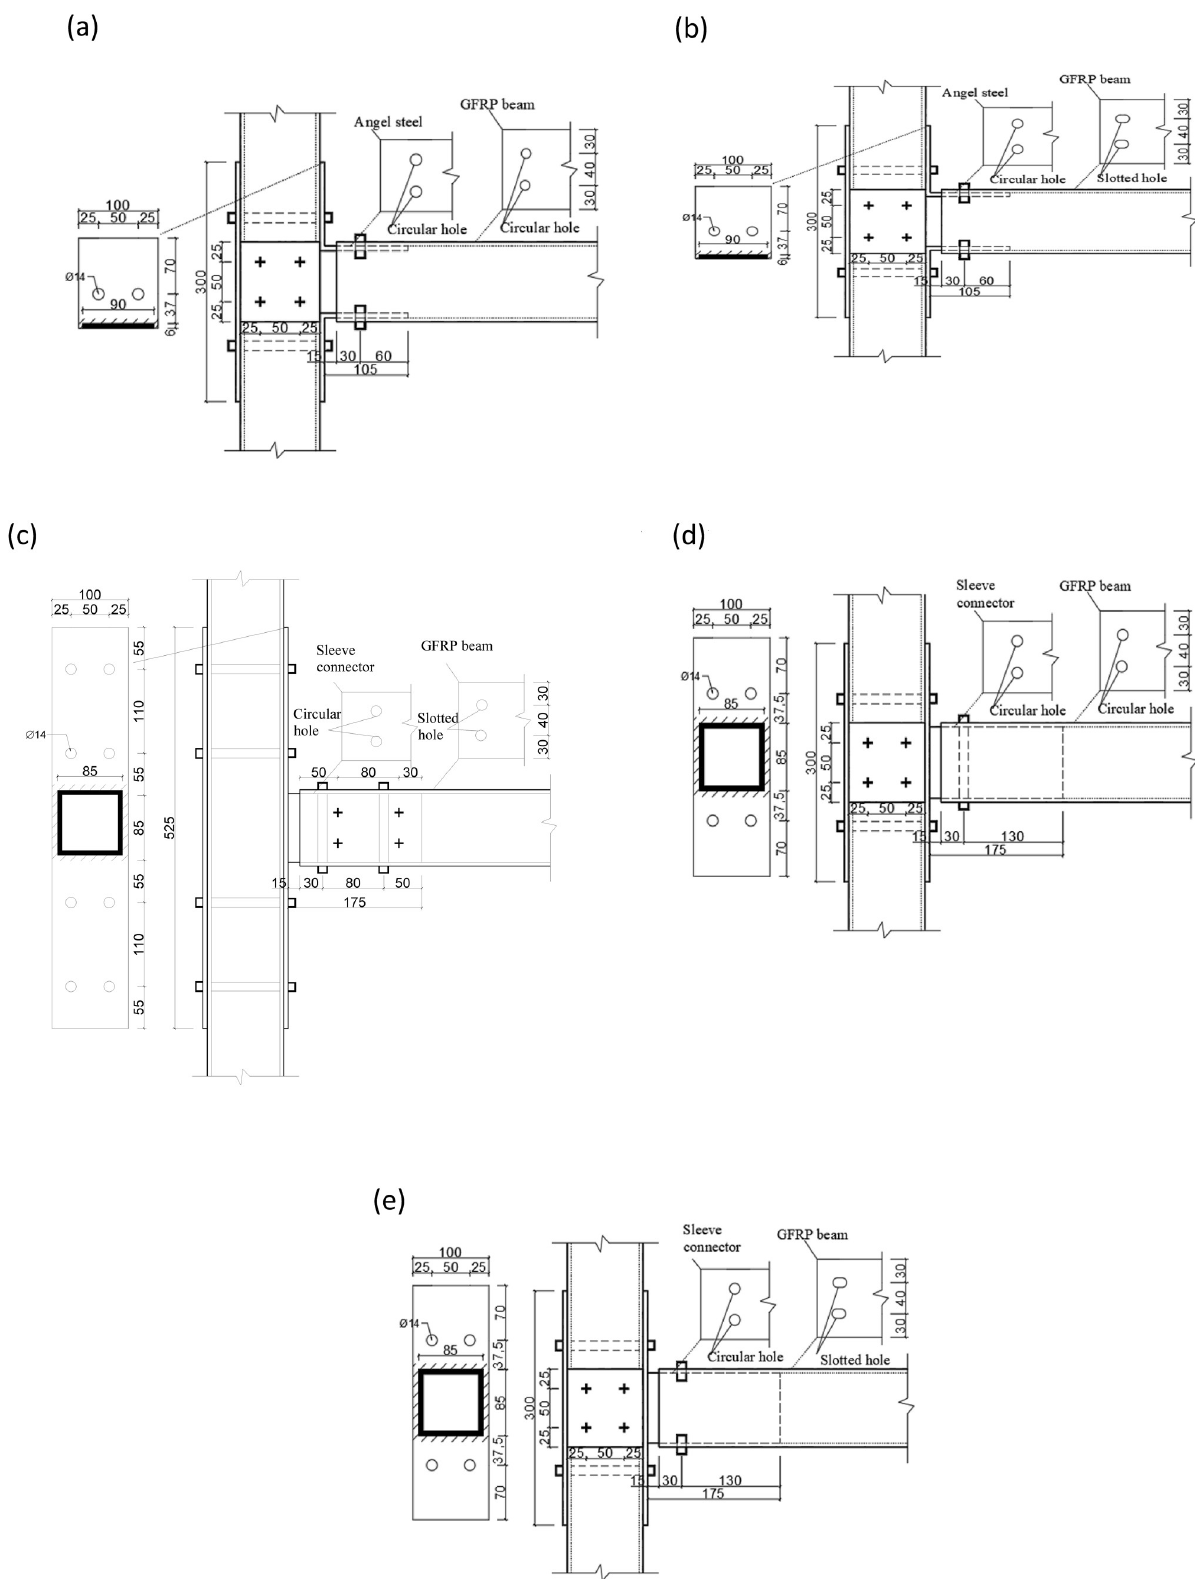
Fig 1. Details of specimens. (a) J1;(b)J2;(c)T1;(d)T2;(e)T3. https://doi.org/10.1371/journal.pone.0272136.g001 PLOS ONE | https://doi.org/10.1371/journal.pone.0272136 July 27,